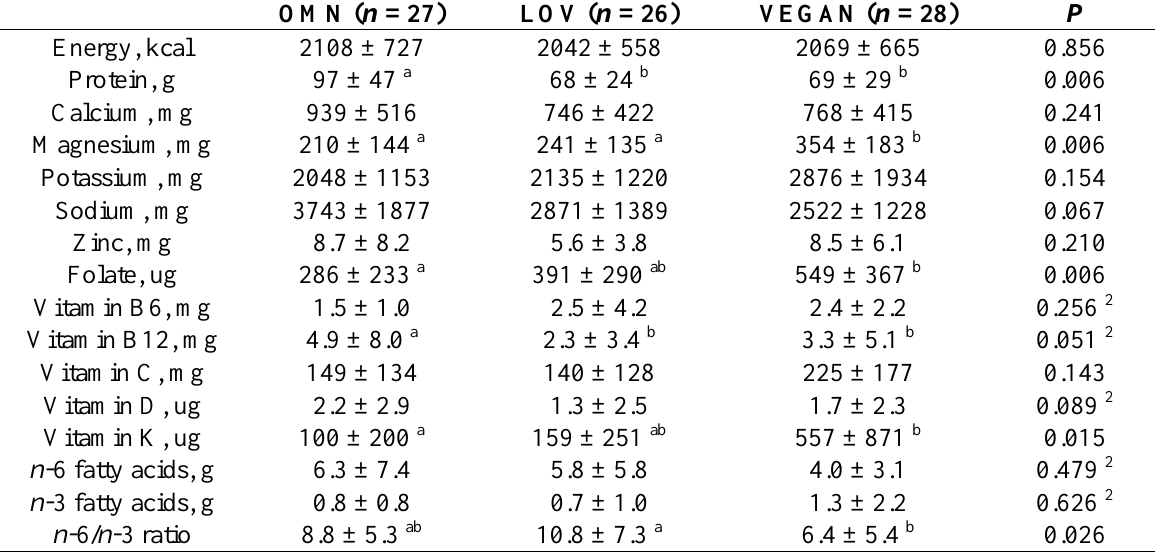
Table 3. Dietary intake for nutrients associated with bone health by diet group (omnivorous, OMN; lacto-ovo vegetarian, LOV; vegan, VEGAN) 1 .